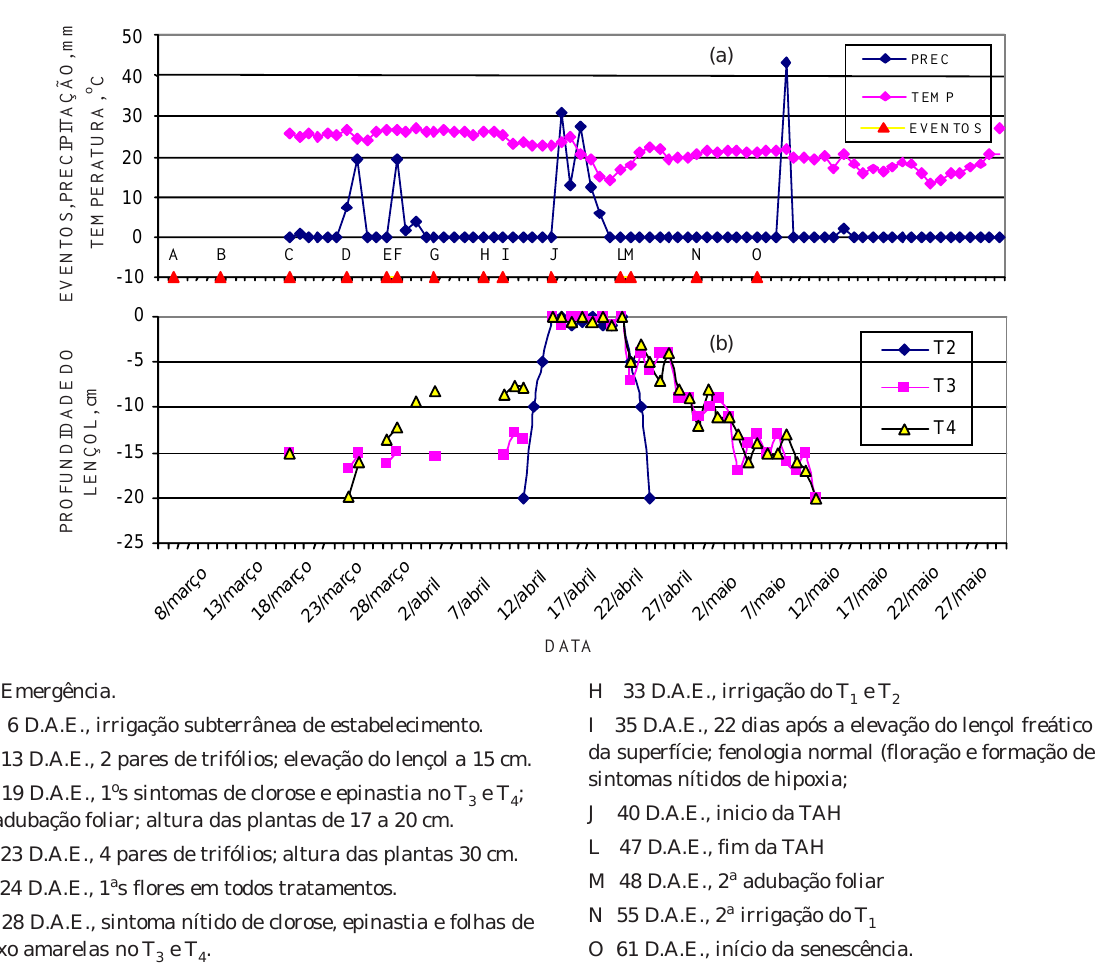
Figura 3. Seqüência de eventos, precipitação e temperatura média ocorridas ao longo do ciclo fenológico do feijoeiro (a); Flutuação do lençol ocorrida durante o ciclo fenológico da cultura (b).